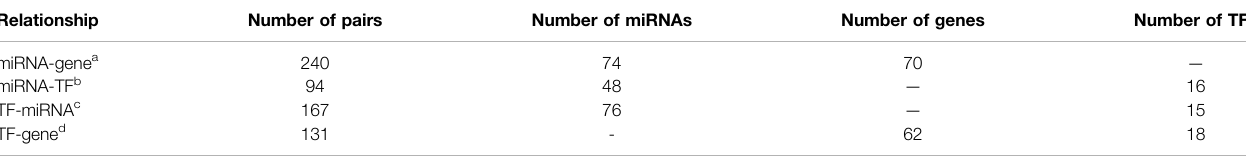
TABLE 1 | Summary of four types of regulatory relationships among IS-related miRNAs, immune genes, and TFs. Relationship Number of pairs Number of miRNAs